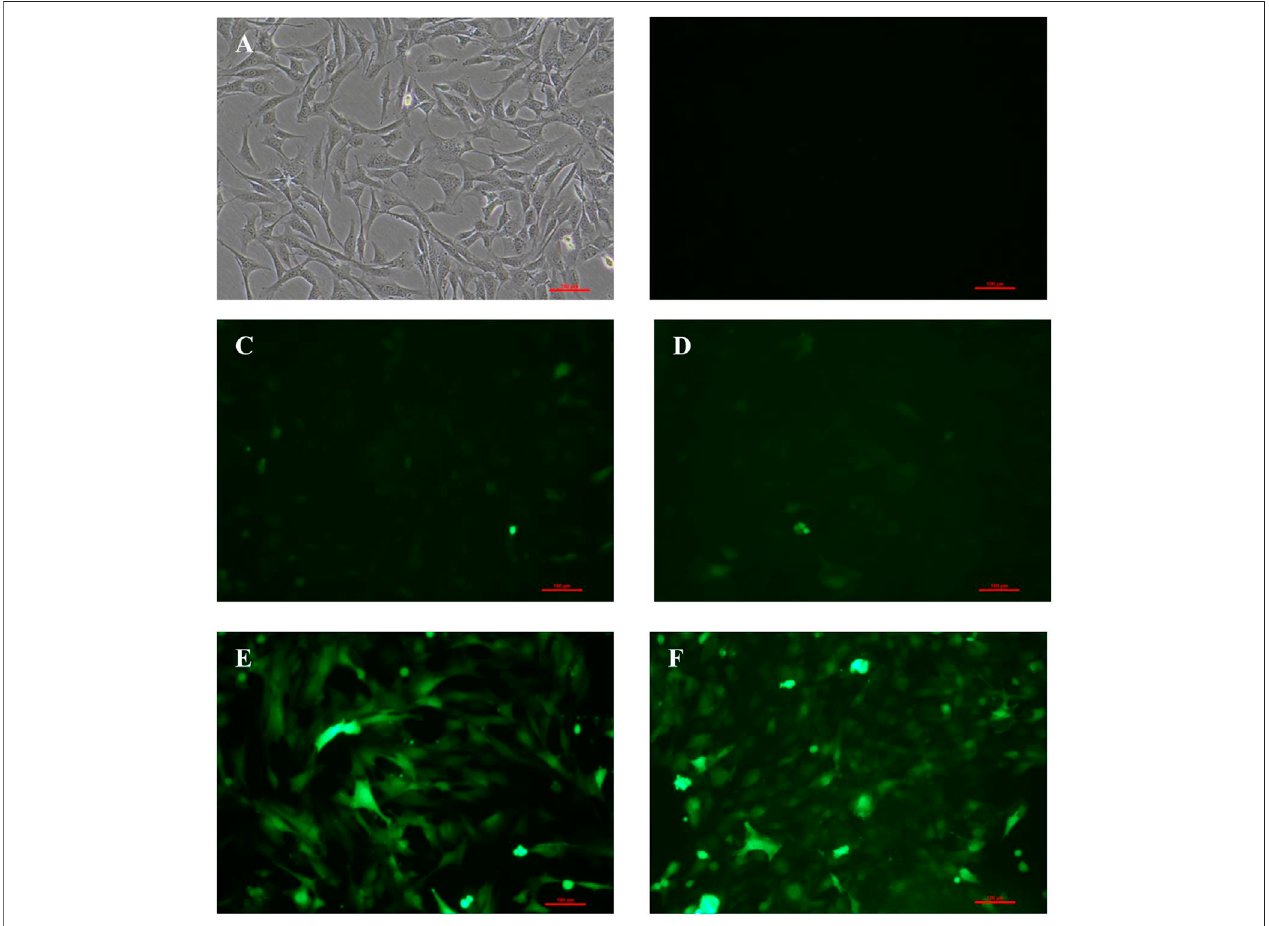
FIGURE 2 | Infection rate of control adenovirus in MSCs detected by fl ow cytometry. MOI (cid:2) 200. n (cid:2) 3 per group.